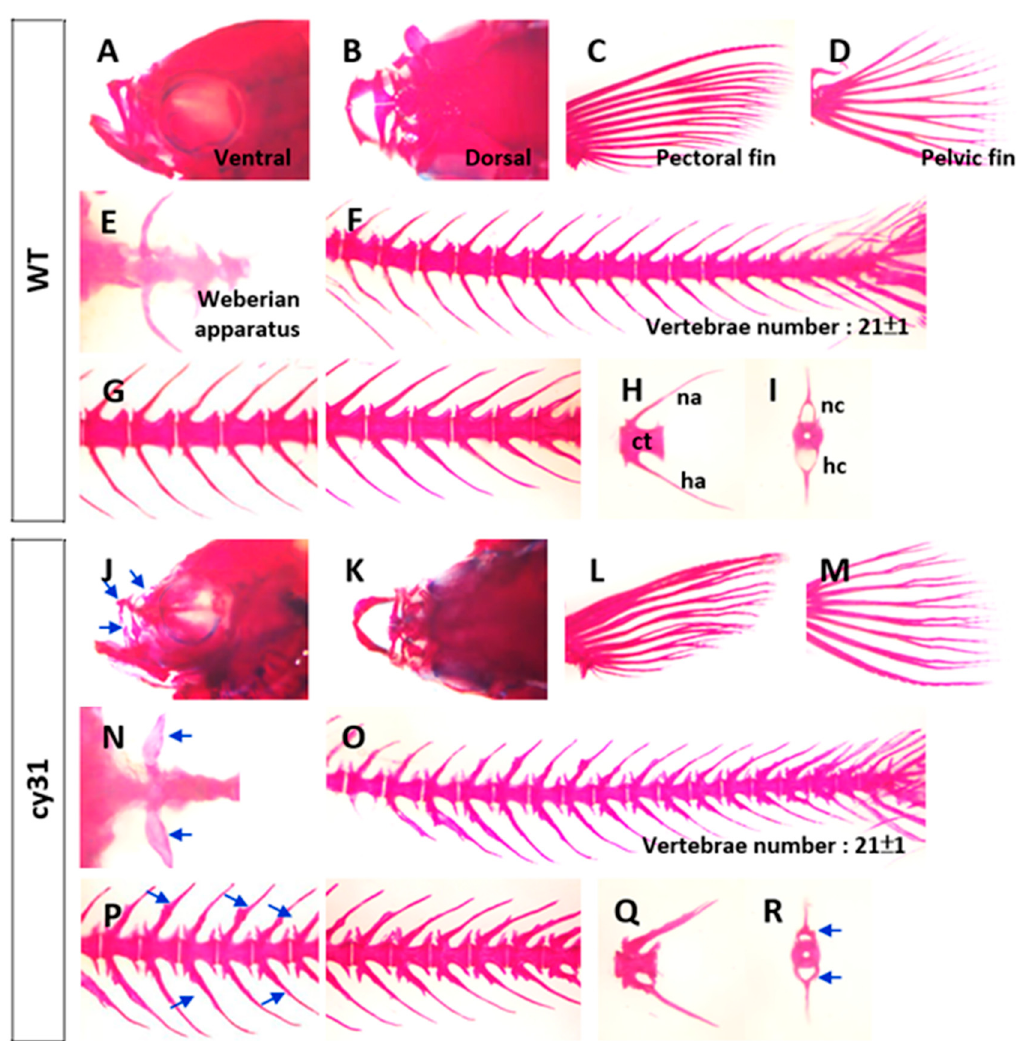
Figure 4. Alcian blue/Alizarin red double staining in different skeletal regions of wild type fish ( A – I ) and Tg(Ola.Sp7:N1aICD) cy31 transgenic fish ( J – R ). Bone morphologies of maxilla from lateral ( A , J ) and dorsal views ( B , K ), pectoral fin ( C , L ), pelvic fin ( D , M ), Weberian apparatus ( E , N ), vertebrae ( F , O ), and neural and hemal arches from lateral ( H , Q ) and anterior ( I , R ) views were magnified respectively. Blue arrows indicated the abnormal formation of outgrowing knots (centrum, ct; neural arch, na; hemal arch, ha; neural canal, nc; hemal canal, hc).